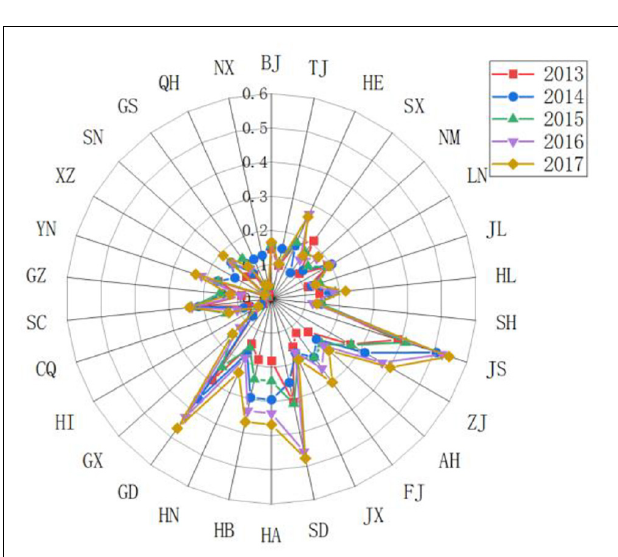
FIGURE 5 | Comparing the scores of the sports development resilience status subsystem in various provinces in China.